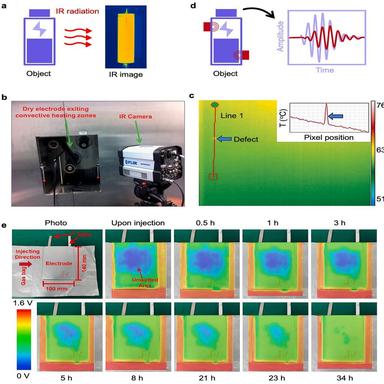
Infrared imaging of battery electrode defects and ultrasound imaging of electrolyte wetting in pouch cells. (a) A schematic illustration of infrared imaging. (b) IR thermography set-up to measure the defect in dried electrode coming out from the slot-die coater. (c) The IR image and line profile showing the presence of a local defect in the electrode. Reproduced with permission. Copyright 2014, RSC. (d) A schematic illustration of using acoustic probe for sensing a battery cell. (e) Ultrasonic